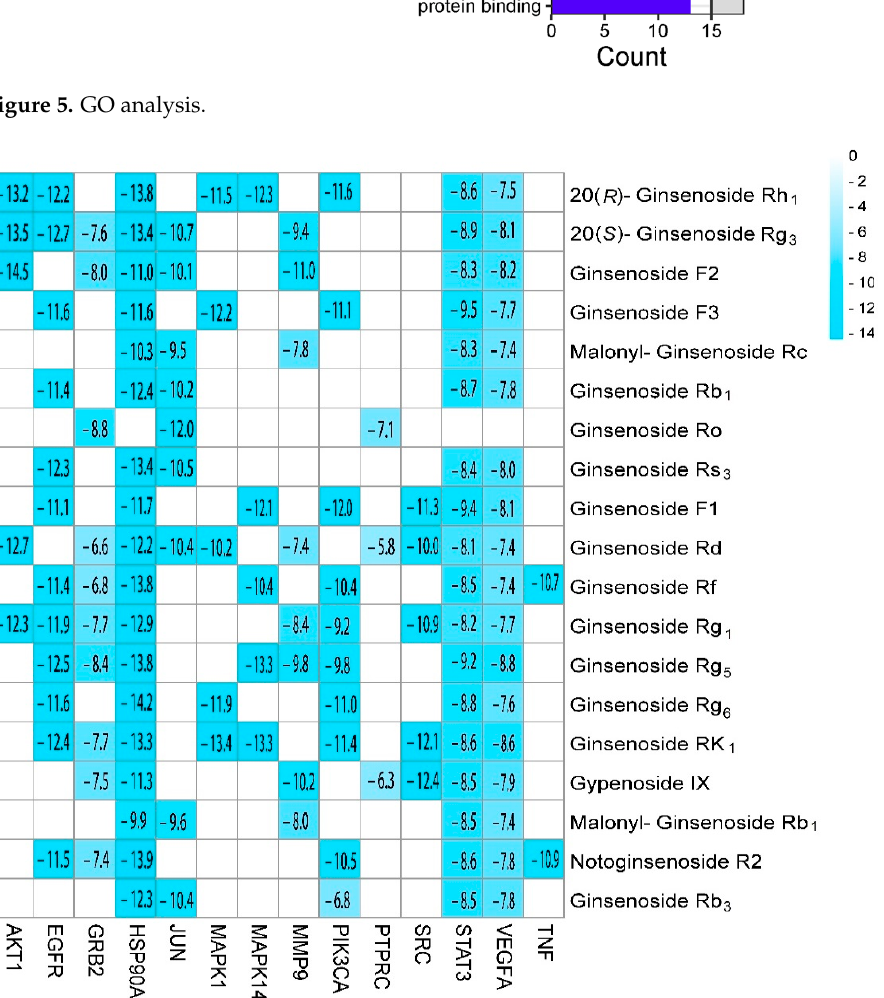
Figure 6. The binding energy of molecular docking between the nineteen identified ginsenosides and the fourteen core targets.